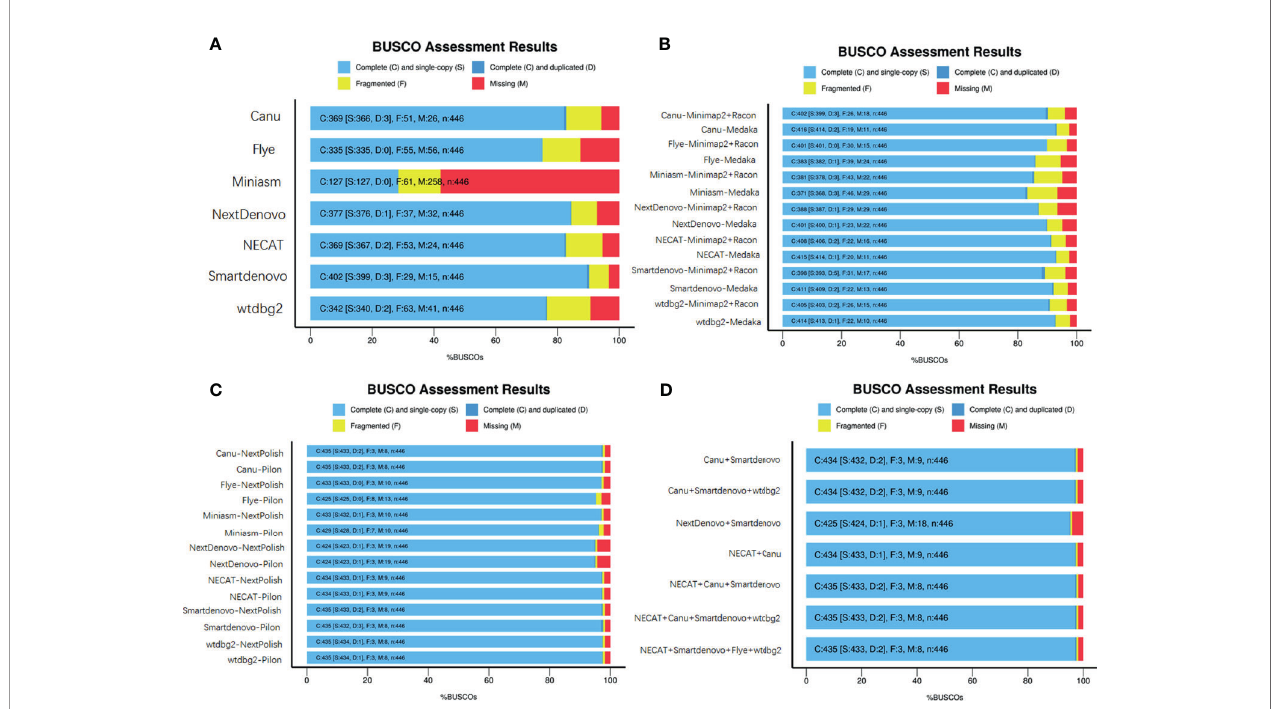
FIGURE 2 | Assessment of genome assemblies using BUSCO. (A) Outputs from assemblies without further base correction; (B) Assemblies corrected using Minimap2 + Racon or Medaka with ONT reads; (C) Assemblies corrected using NextPolish or Pilon with Illumina reads; (D) Merged multiple assemblies corrected with nanopore and NGS